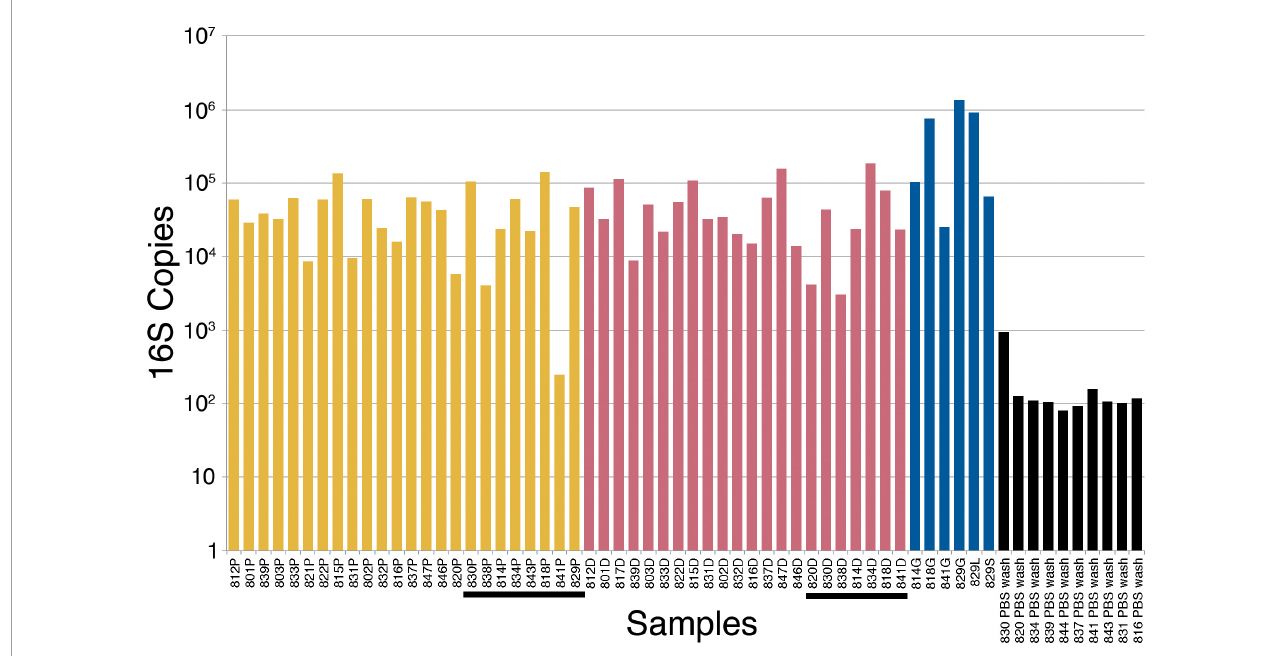
FIGURE1 16S ribosomal ribonucleic acid (rRNA) gene polymerase chain reaction (PCR) bacterial quantification in placenta (yellow), decidua (red), fetal tissue (blue), and PBS wash (black) samples. The tissue samples are in order of increasing gestational age from left to right. Post-perfusion (10 weeks gestational age and above) placental and decidual samples are underlined. P, placenta; D, decidua; G, gut (intestine); S, spleen; L, liver; PBS, phosphate-buffered saline.